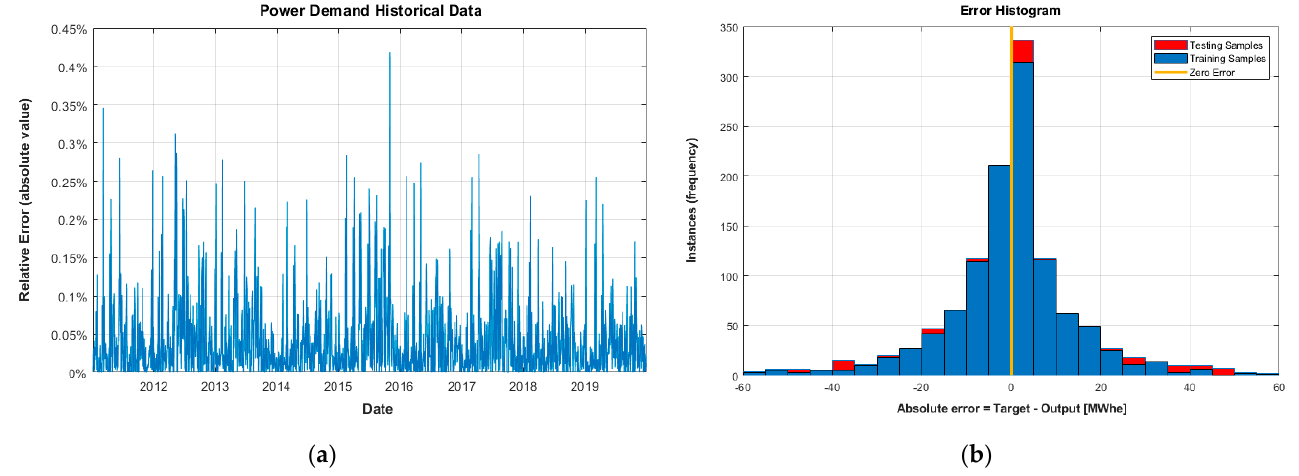
Figure 12. Power demand historical data error: ( a ) relative error; ( b ) absolute error histogram grouped by sample type (note that x axis values are in MWhe).